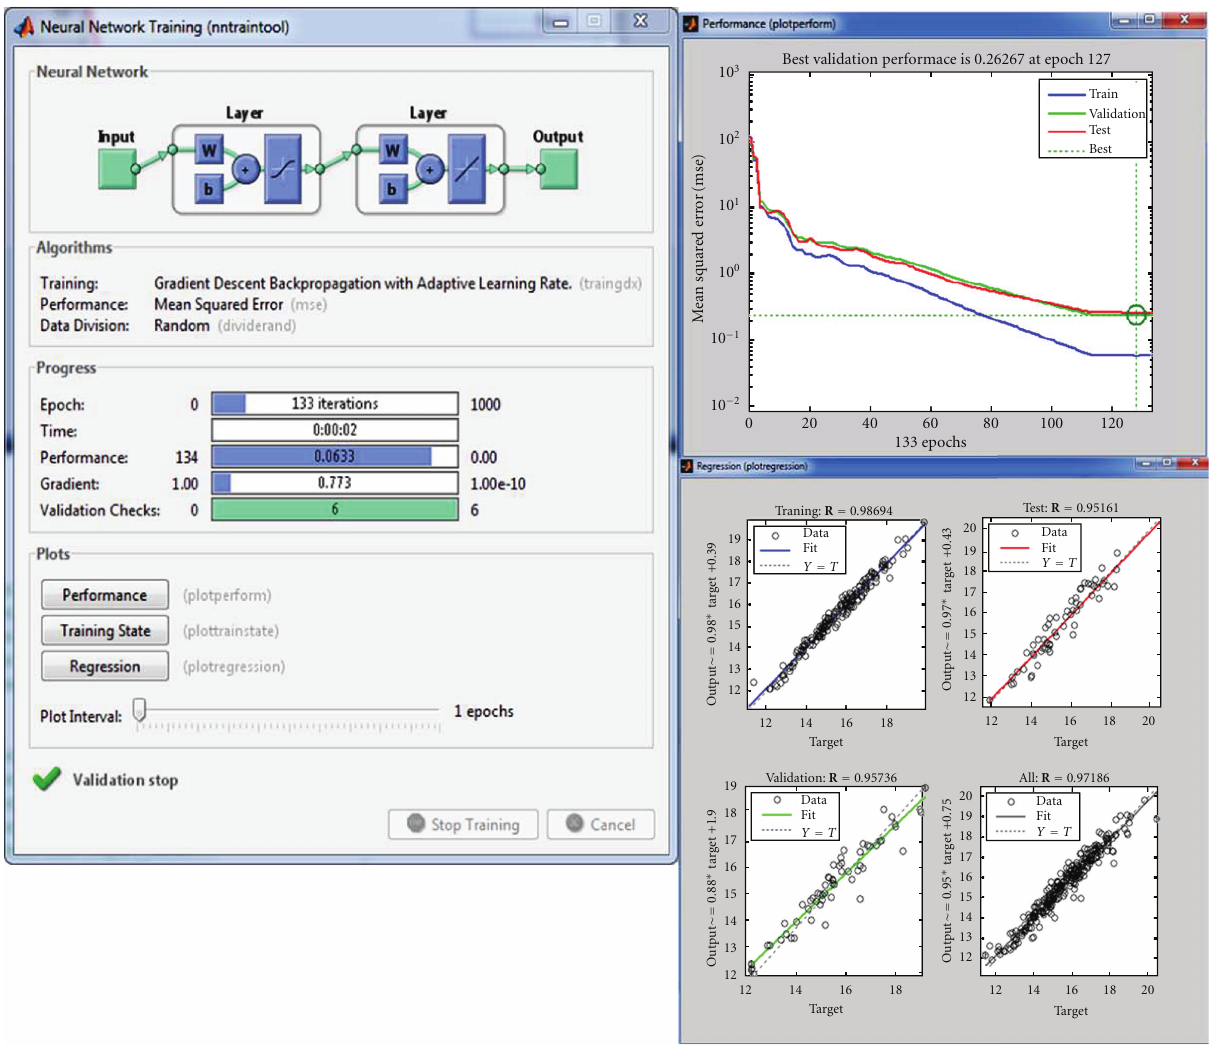
Figure 4: ANN structure and training. Gradient Descent Back propagation with adaptive learning rate has been used for training the ANN. The performance function (MSE) the regression, and the number of iterations are